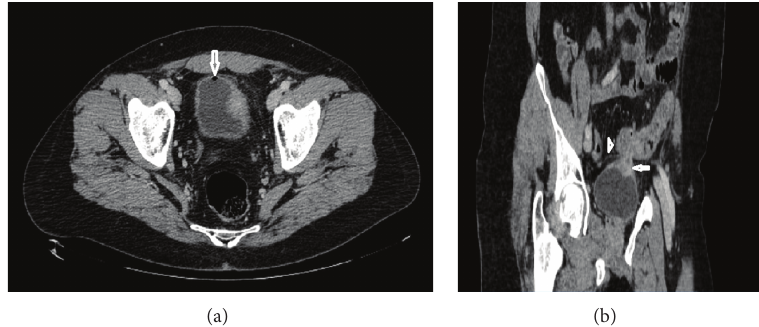
Figure 4: Colovesical fistula: axial image of contrast enhanced CT of the abdomen and pelvis demonstrates air in the bladder (arrow) and thickened left bladder wall (a); sagittal image shows bladder wall thickening (arrow) adjacent to a loop of thickened sigmoid colon (arrow head)